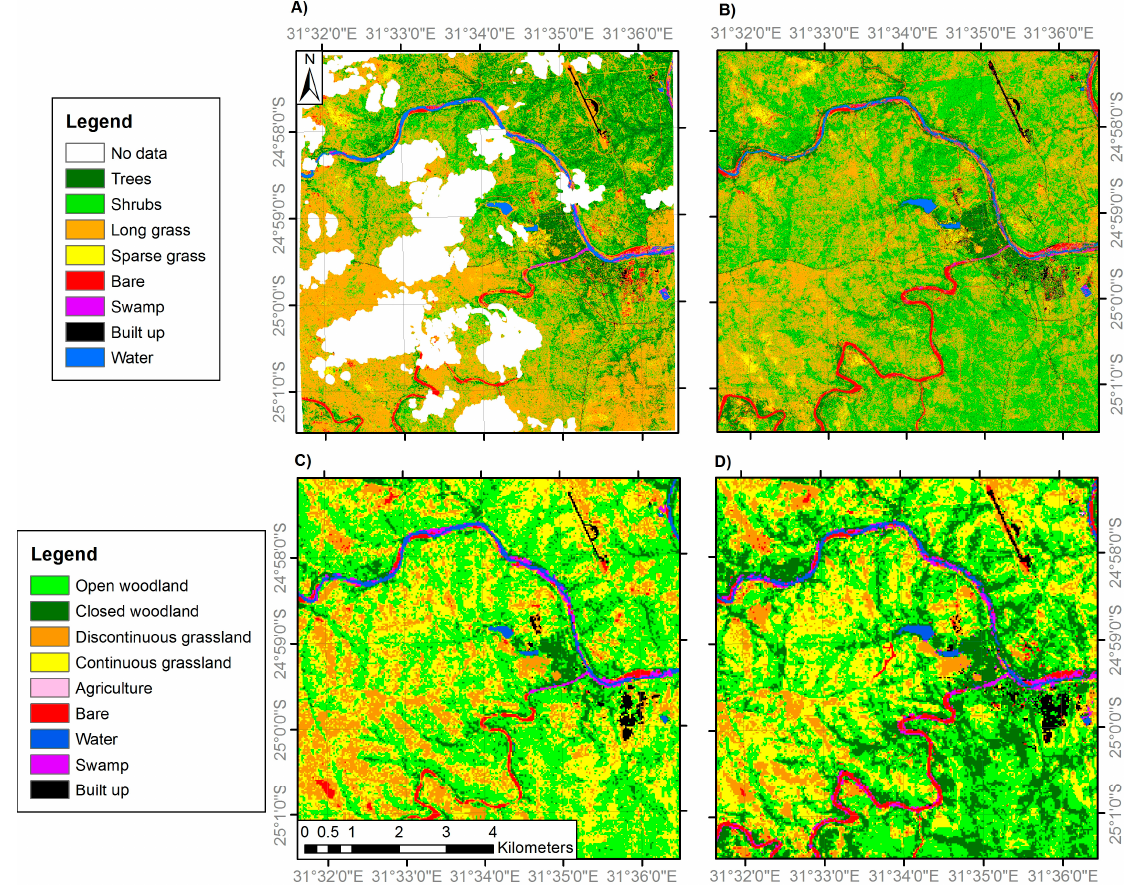
Figure 3. Land cover classifications of site 1 generated from: ( A ) VHR QuickBird imagery (2.8 m resolution) in 2002; ( B ) VHR WorldView-2 imagery (resampled to 2.8 m) in 2014; ( C ) medium resolution Landsat ETM+ imagery (30 m) in 2002; and ( D ) medium resolution Landsat OLI imagery (30 m) in 2014. Areas of ‘No Data’ correspond to areas of cloud cover and cloud shadow. Note the woodland and grassland class definitions differ between the fine and medium resolution classifications (Table 2).